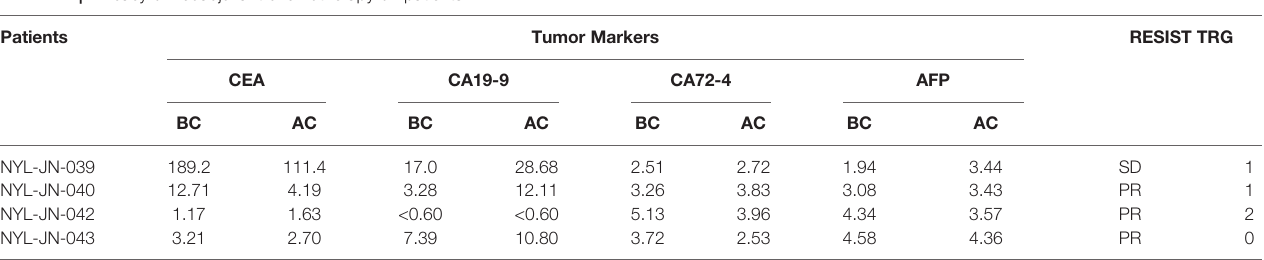
TABLE 4 | Ef fi cacy of neoadjuvant chemotherapy on patients.